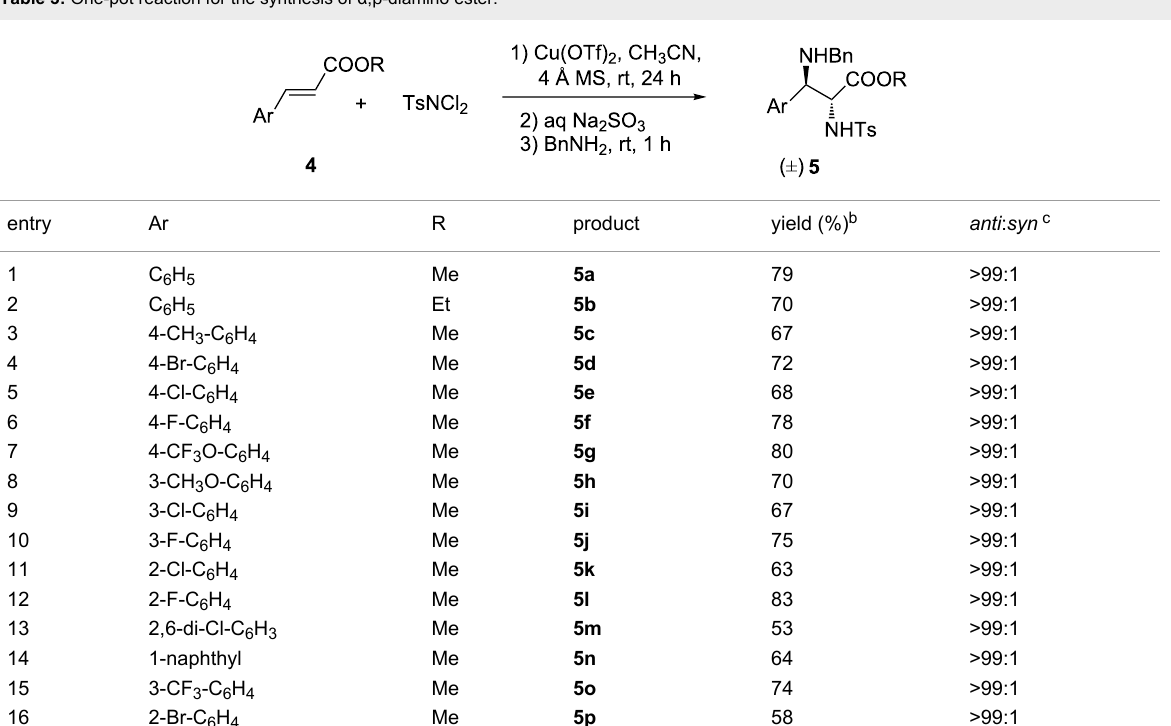
Table 3: One-pot reaction for the synthesis of α , β -diamino ester. a